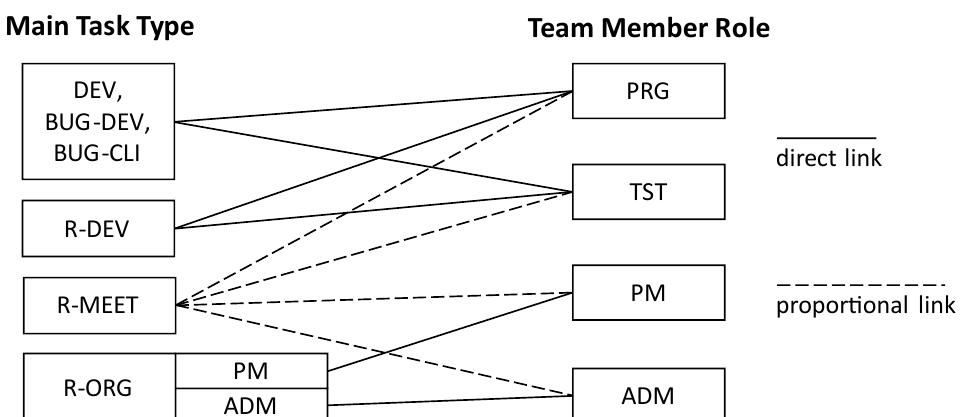
Figure 11. Relationship between the main types of tasks and the roles of project team members performing them.